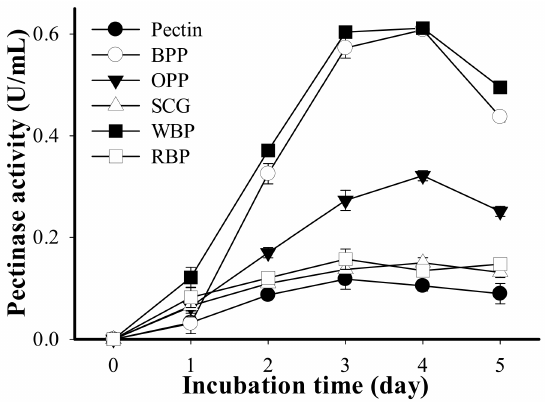
Figure 1. Screening of a 1% ( w / v ) suitable C source for pectinase production by B. amyloliquefa- ciens TKU050, including BPP (banana peel powder), OPP (orange peel powder), SCG (spent coffee grounds), WBP (wheat bran powder), and RBP (rice bran powder). All error bars are the ±